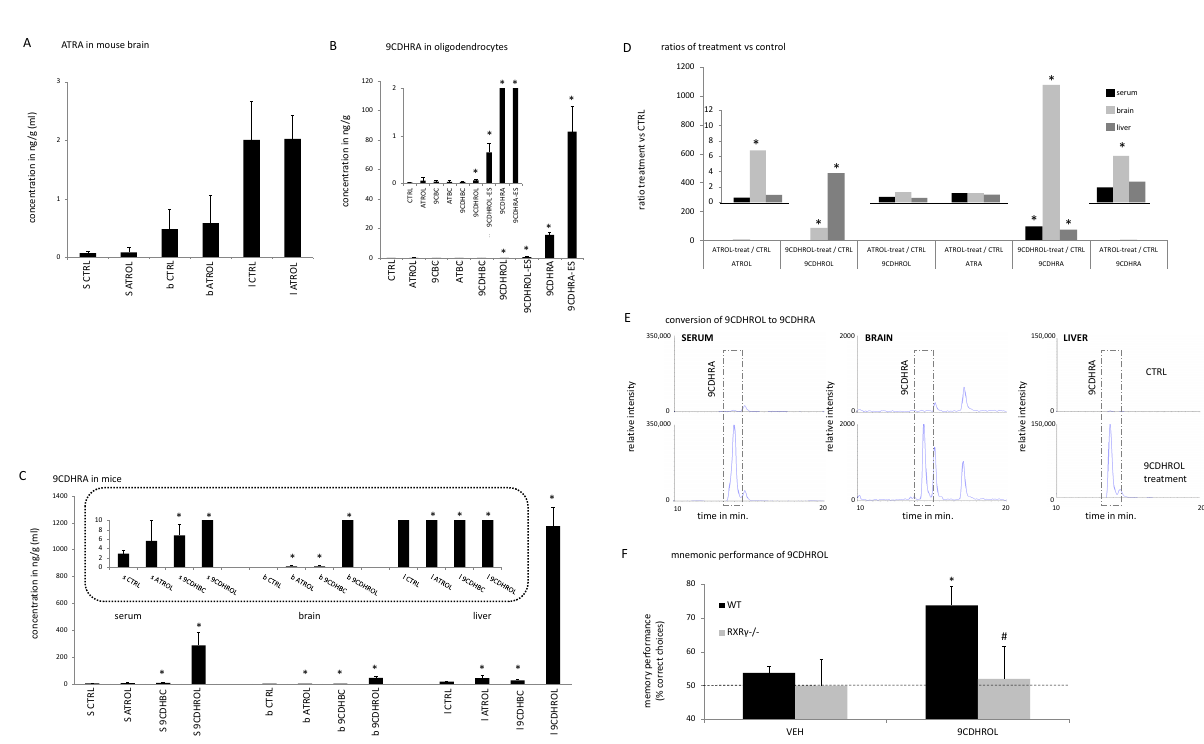
Figure 3. Endogenous and nutritionally-relevant precursors of 9CDHRA and specific RXR-mediated signaling properties of 9CDHROL . ( A ). Concentrations of ATRA in serum (s), brain (b) and liver (l). All- trans -retinoic acid (ATRA) levels before and after retinol treatment in serum, brain and liver, each n = 5. ( B ). 9CDHRA levels including standard deviation in cultured mouse oligodendrocytes after treatment with ethanol (CTRL), or ATROL-, 9CBC-, ATBC-, 9CDHBC-, 9CDHROL-, 9CDHROL-ES-, 9CDHRA and 9CDHRA-ES, each at 10 − 6 M and n = 3 ( € ). ( C ). 9CDHRA levels including standard deviation in mouse organs (each n = 5, s—serum, b—brain, l—liver) after control treatment (CTRL), ATROL-, 9CDHBC- or 9CDHROL-treament each with an oral gavage of 40 mg/kg ( € ). ( D ). Concentrations of lipid hormones and nuclear hormone receptor activating ligands (ATRA and 9CDHRA) as well as their nutritional precursors (ATROL and 9CDHROL) in serum (s), brain (b) and liver (l) summarized for 9CDHROL and ATROL. Summarized ratios of substance treatment (treat) vs. CTRL treatment (CTRL), specifically for “ATROL”: ATROL-treat/CTRL, “9CDHROL”: 9CDHROL-treat/CTRL, or ATROL-treat/CTRL and for “ATRA”: ATROL-treat/CTRL and for “9CDHRA”: 9CDHROL-treat/CTRL or ATROL-treat/CTRL ( € ). ( E ). Conversion of 9CDHROL to 9CDHRA, 9CDHRA standard levels (including also ATDHRA as a small later eluting peak) in serum, brain and liver after control-treatment (CTRL, endogenous level, top chromatograms) and after 9CDHROL-supplementation (bottom chromatograms) in mice using the same y -axis scale (relative intensity in 303 -> 207 m / z ) dimension per relevant organ (serum, brain, liver). After